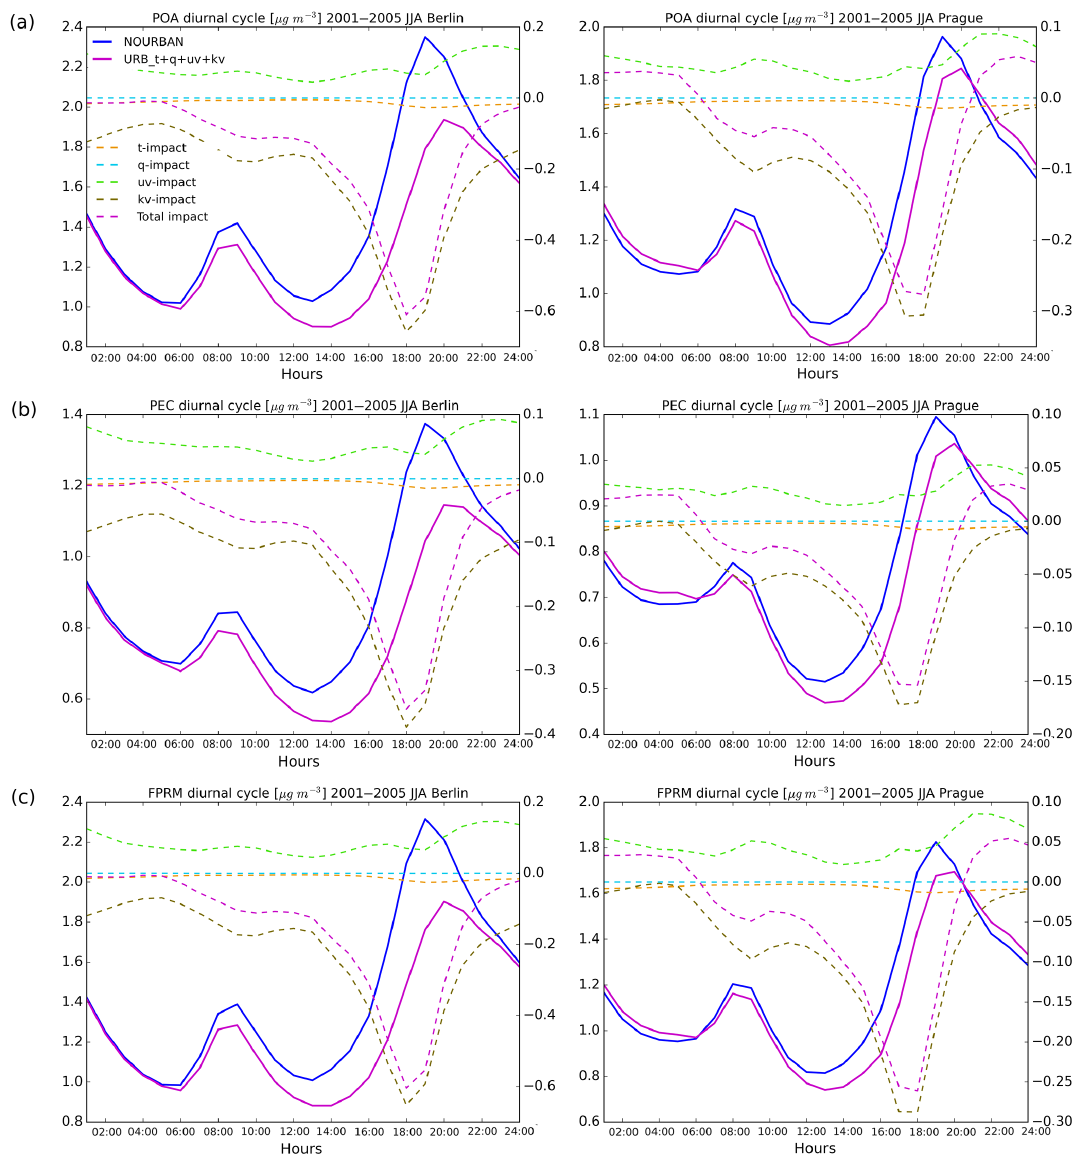
Figure 8. Impact of urban canopy meteorological forcing on (a–c) POA, PEC and FPRM average diurnal cycle of surface concentrations for the 2001–2005 JJA period for two selected cities (Berlin and Prague) in µgm − 3 . Bold lines represent the absolute concentrations (left y axis) for the NOURBAN run (blue) and the total impact URB_t+q+uv+Kv run (purple). Dashed lines (right y axis) show the change due to changes of individual meteorological components (temperature – orange, humidity – aquamarine, wind – green, turbulence – olive and total impact –